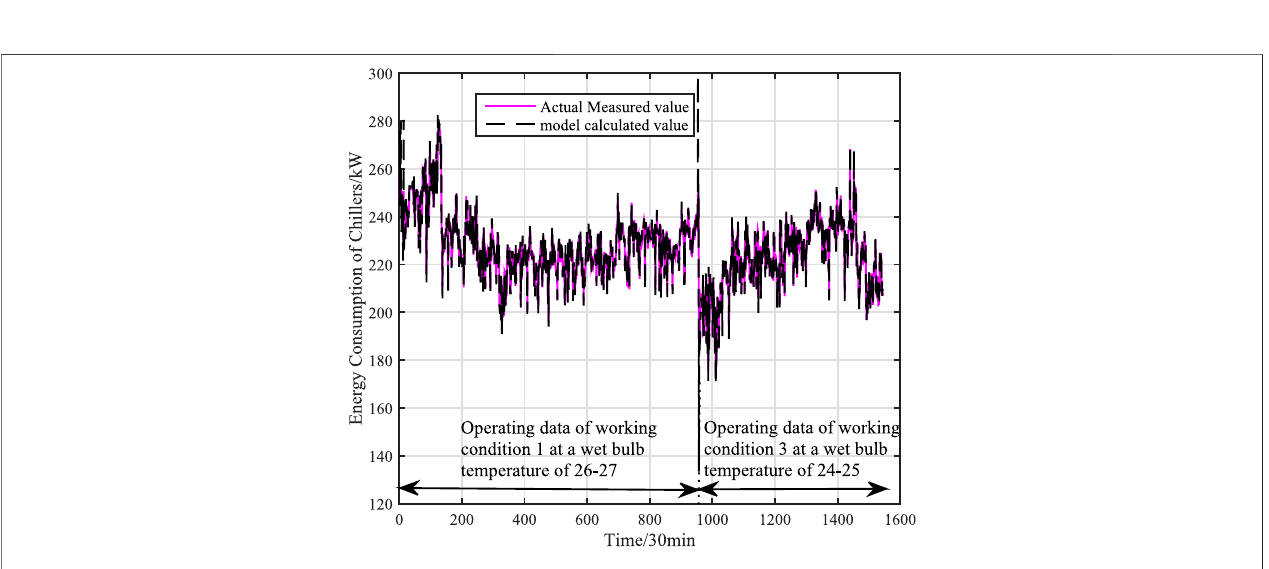
FIGURE 11 | The accuracy of adaptive hybrid model under multiple working conditions (working condition 1 and working condition 3).